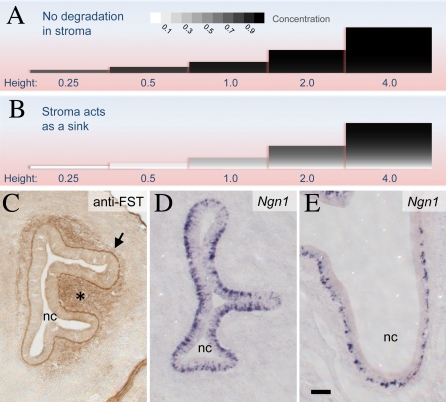
Effects of Geometry and Degradation on Levels of Secreted Molecules within Epithelia(A and B) Polypeptides secreted into the intercellular space of an epithelium are removed by two processes: diffusion into underlying connective tissue (stroma) and degradation within the epithelium. Given a molecule's rate of production, its diffusivity, its rate of uptake and degradation, and the geometry of the epithelium, one may calculate its concentration, at steady state, at every location within the epithelium. Here, such calculations are shown graphically, for epithelia of different thicknesses (in each picture, the epithelium is oriented with the apical surface at the top). Epithelial thickness (“height”) is scaled according to the decay length of the molecule of interest. The shading in each picture depicts the concentration of the secreted molecule, with black representing the limiting concentration that would be achieved in an epithelium of infinite thickness. In (A), the degradation capacity of the stroma is set at a relatively low value, one-tenth of that in the epithelium. In this case, intraepithelial concentrations of secreted molecules plateau while the epithelium is very thin. In (B), the degradation capacity of the stroma is ten times of that in the epithelium, so that few molecules that enter the stroma escape undegraded. Now, there is a large (and more physiological) range of epithelial thickness over which the concentrations of secreted molecules change appreciably with tissue size. This is particularly true near the basal surface of the epithelium (see also Figures S27 and S28 in Protocols S1–S3).(C) Follistatin (FST), a molecule that binds GDF11 and activin essentially irreversibly, is present at high levels in the basal lamina (arrow) and stroma (asterisk) beneath the embryonic day 13 OE. Association of FST with basal laminae is consistent with its affinity for extracellular matrix components [102]. Scale bar represents 100 μm.(D and E) INPs (visualized with Ngn1 in situ hybridization) become progressively localized to the basal surface of the OE over the course of development. (D) = embryonic day 12.5; (E) = embryonic day 18.5. nc = nasal cavity. Scale bar in (E) represents 100 μm.